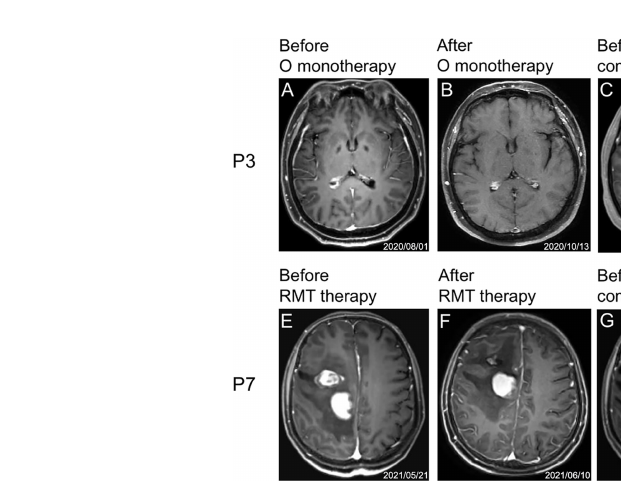
FIGURE 3 | Representative MRI images of two patients (P3 and P7) during treatment. (A – D) and (E – H) are MRI images of the treatment process of P3 and P7, respectively. (A) Before orelabrutinib therapy. (B) After orelabrutinib therapy. (C) Before combination therapy. (D) After combination therapy. (E) Before RMT therapy. (F) After RMT therapy. (G) Before combination therapy. (H) After combination therapy.